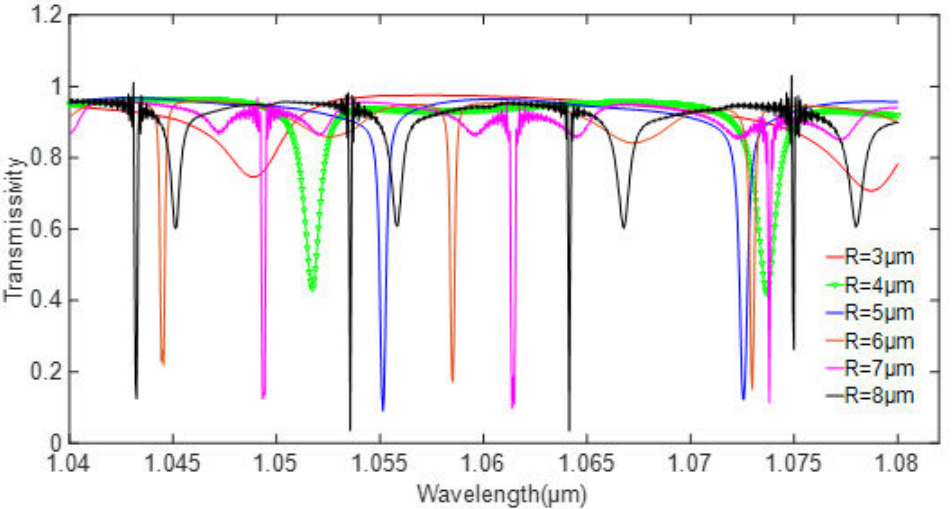
Figure 5. Relationship between the transmissivity and the radius of the silicon nitride